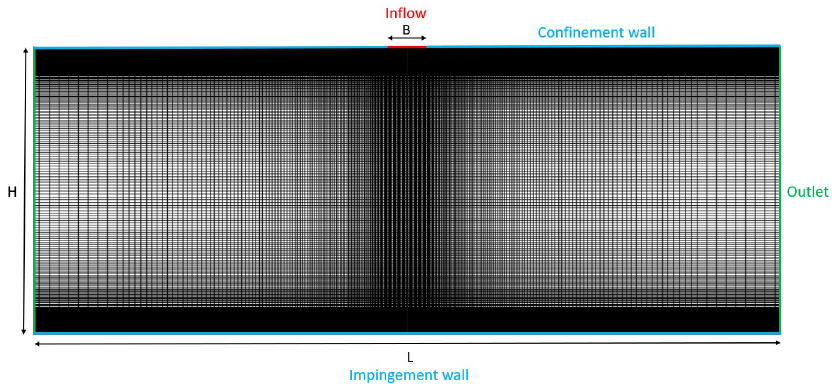
Figure 3. Schematic of the computational